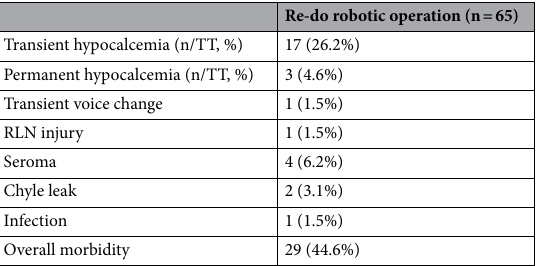
Table 3. Postoperative complications of re-do robotic operation. Data are expressed as patient number (%). TT total thyroidectomy, RLN recurrent laryngeal nerve.